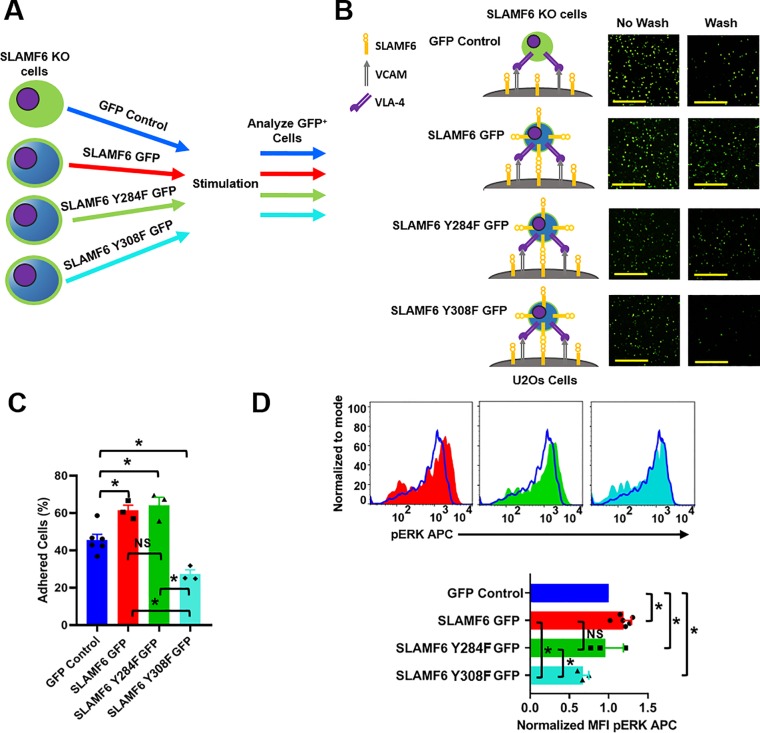
SLAMF6 tyrosine 308 is crucial for its ability to promote adhesion.(A) A schematic of the assay used to analyze SLAMF6 endodomain function. (B) SLAMF6 KO Jurkat T cells were transfected with GFP control, SLAMF6 GFP, SLAMF6 Y284F GFP and SLAMF6 Y308F GFP and co-cultured with U2Os cells stably expressing SLAMF6 and VCAM in the presence of αCD3 for 20 min at 37°C. They were then imaged before and after four washes. Scale bar is 100μm. (C) Quantification of number of adhered cells for at least three independent experiments of SLAMF6 KO Jurkat T cells transfected with GFP control, SLAMF6 GFP, SLAMF6 Y284F GFP and SLAMF6 Y308F GFP (bottom) (n = 3–6). *p<0.05 for an unpaired student t-test. (D) Representative histograms analyzing pERK APC for SLAMF6 KO Jurkat T cells t (top). SLAMF6 KO Jurkat T cells were transiently transfected with GFP control, SLAMF6 GFP, SLAMF6 Y284F GFP and SLAMF6 Y308F GFP. Cells were treated with αCD3 + cross linker, stimulated at 37° C for 5 min, fixed permeabilized, stained and subjected to flow cytometry. Cells were gated on GFP positive cells and analyzed for pERK APC. Quantification of pERK for at least three independent experiments of SLAMF6 KO Jurkat T cells transfected with GFP control, SLAMF6 GFP, SLAMF6 Y284F GFP and SLAMF6 Y308F GFP (bottom) (n = 3–6). *p<0.05 for an unpaired student t-test.